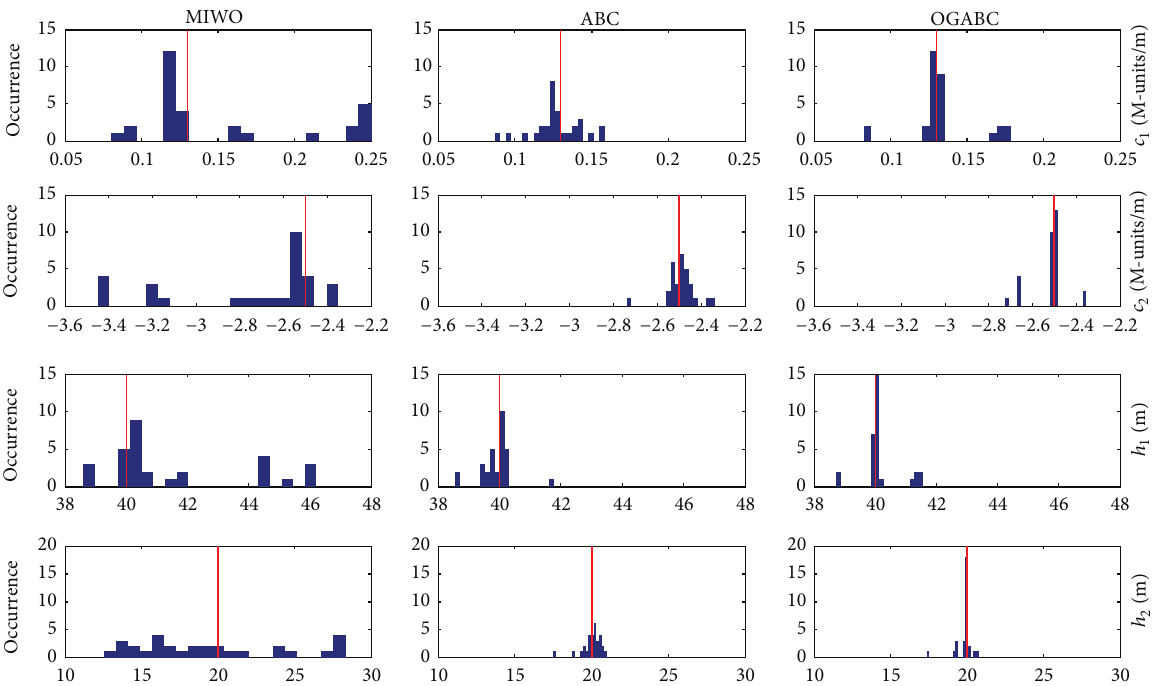
Figure 4: The comparison of the histograms of the inversion results for different algorithms with the noise level of 2dB. among the three algorithms. It is likely due to the fact that the global best search equation not only enhances the global search ability but also avoids falling into the local